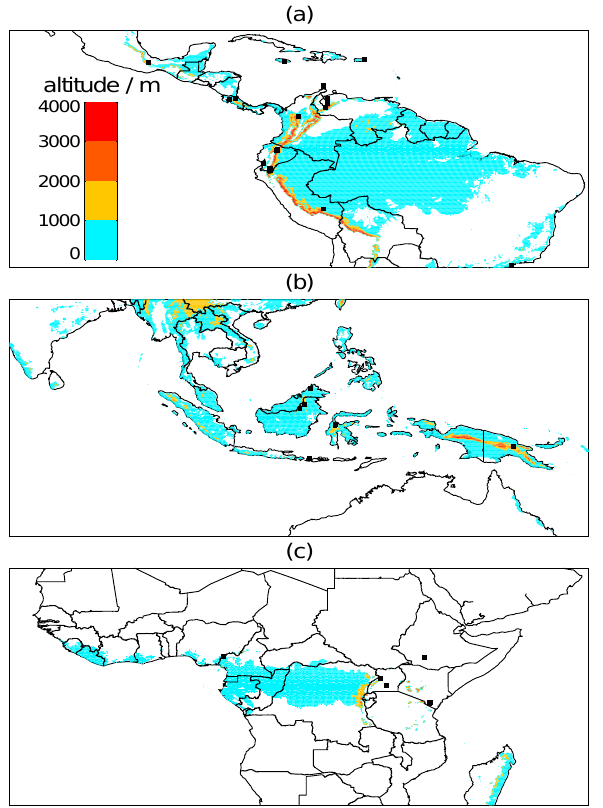
Figure 1. Location of tropical montane forest inventory plots (solid squares) where data of above-ground biomass have been synthe- sized for this analysis in (a) neotropics (sites in Hawaii are not shown here), (b) Asia and (c) Africa. Note that some squares repre- sent multiple plots. Background colour shows elevation of tropical forests (coloured where vegetation continuous field from MODIS is >